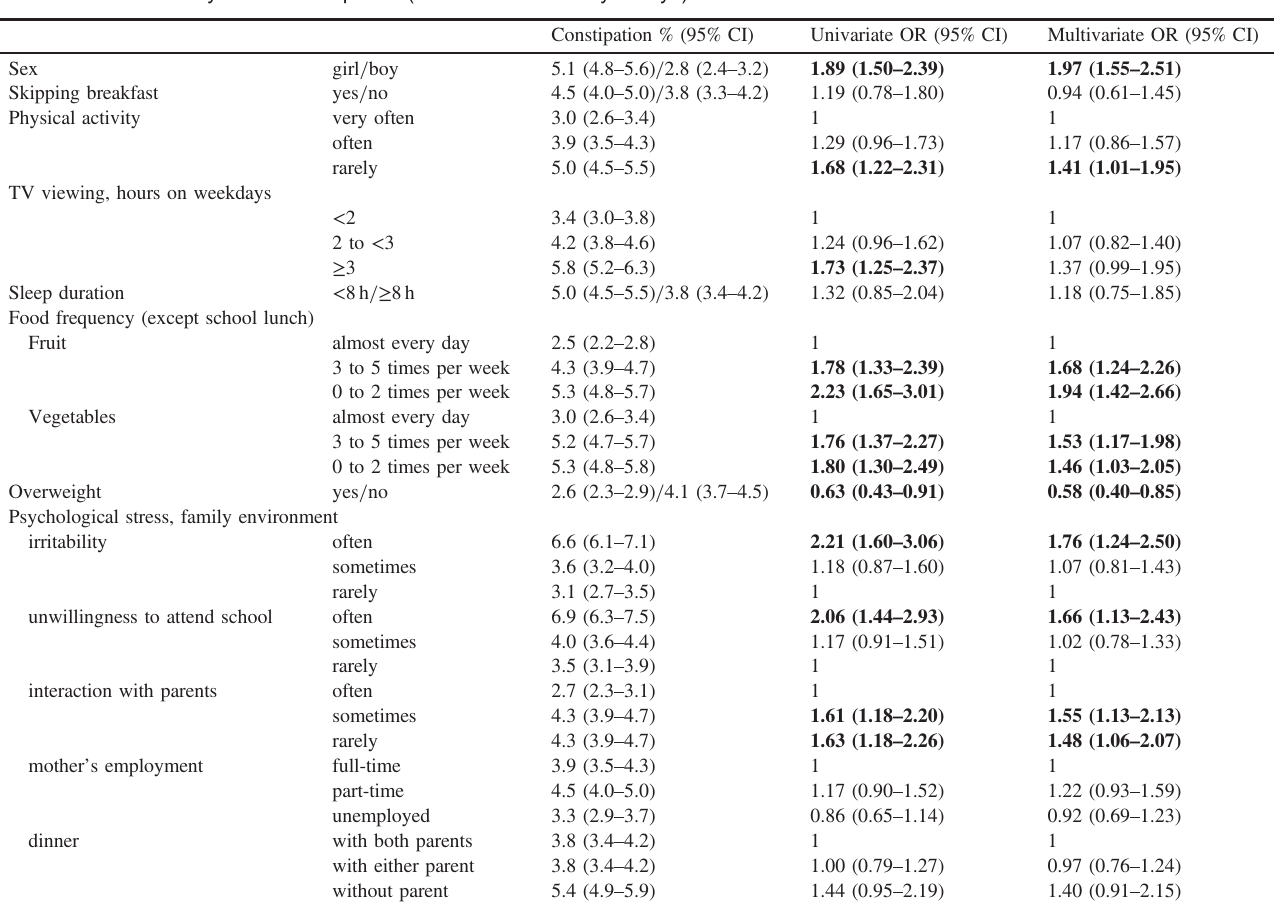
Table 2. Overall analyses on constipation (less than once every 2